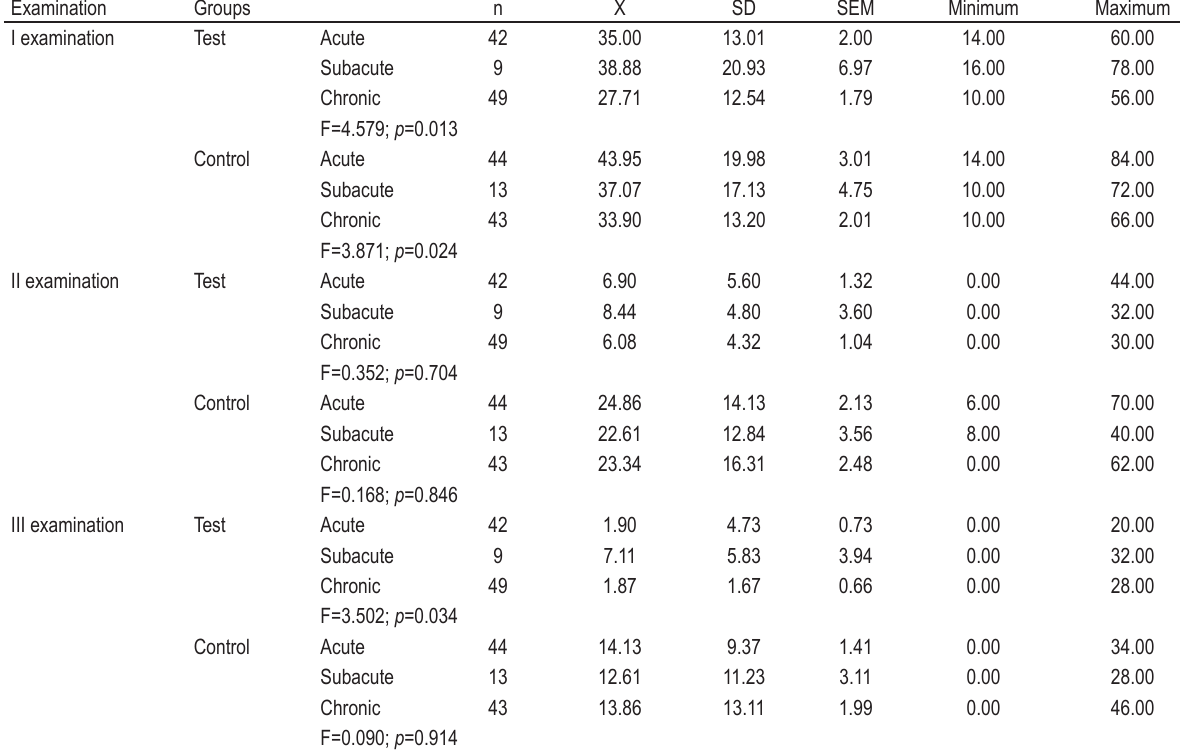
TABLE 9. The influence of the pain type on the disability percentage during all three examinations in both examined